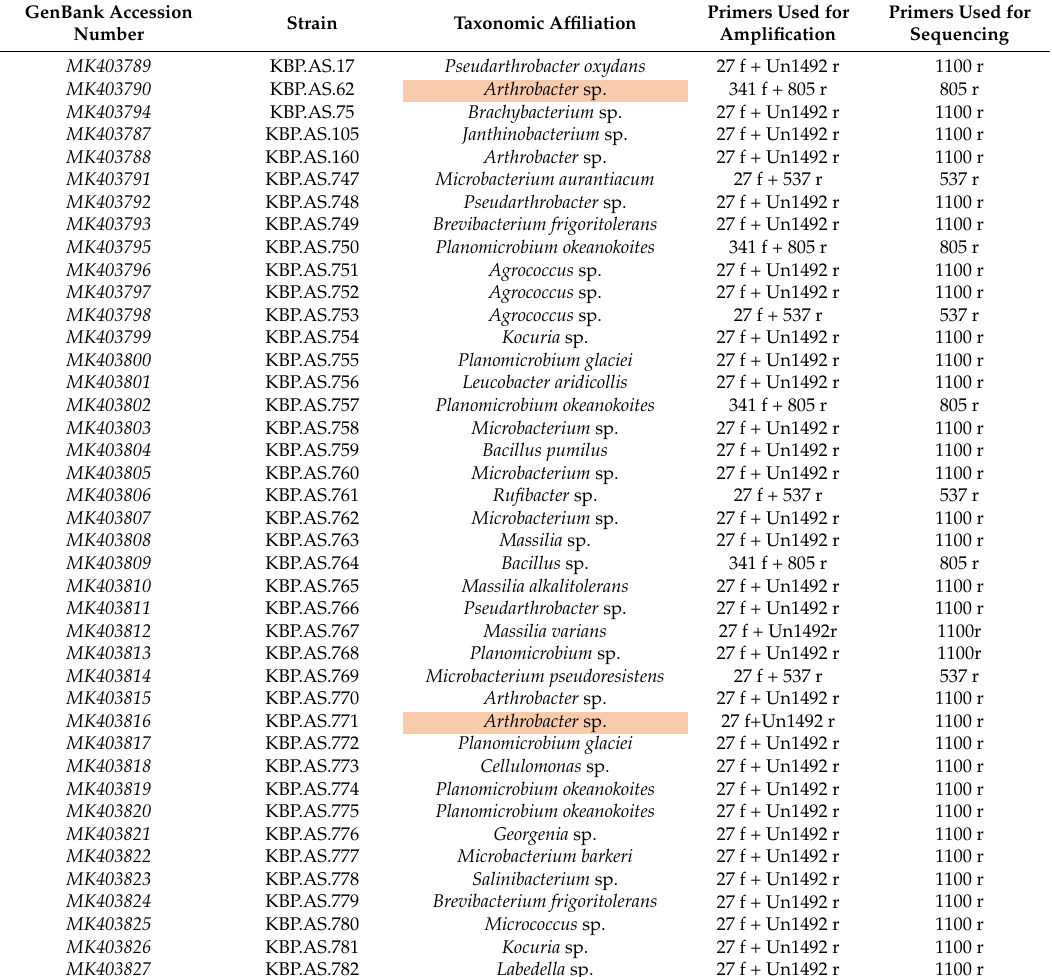
Table A2. The primers used for 16S rRNA gene amplification and